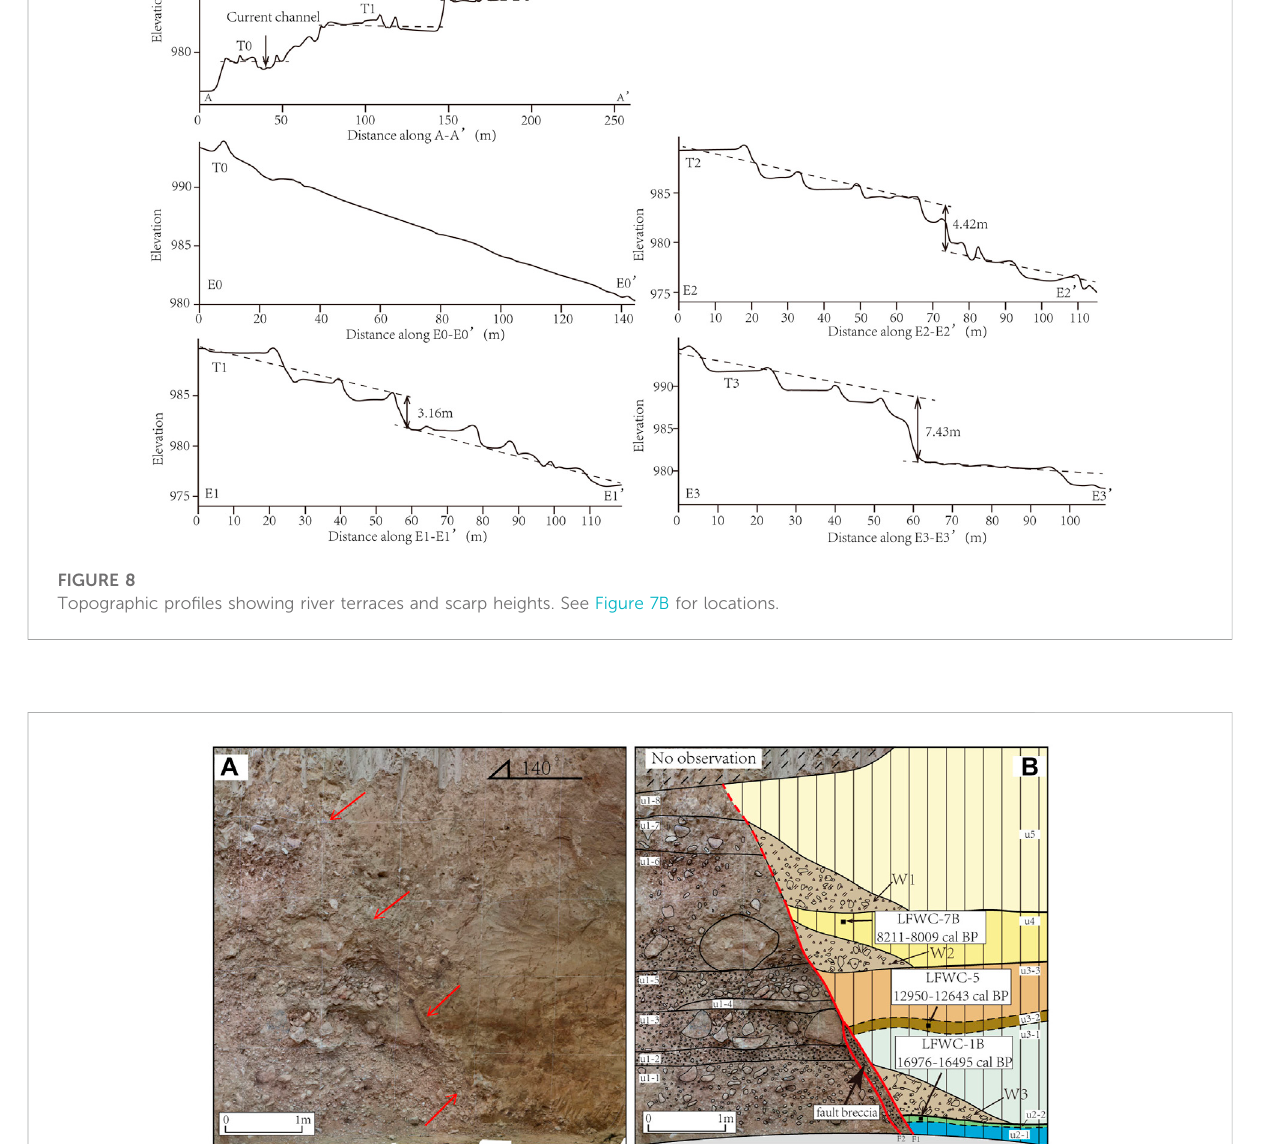
the main tectonic contact between the hanging wall, with mainly loess sediments, and the footwall, with mainly sand and gravel sediments. The fault is present from the top to the bottom of the pro fi le and controls the boundary of the colluvial wedge as the secondary order-faults of F2-1 and F1 have different activity